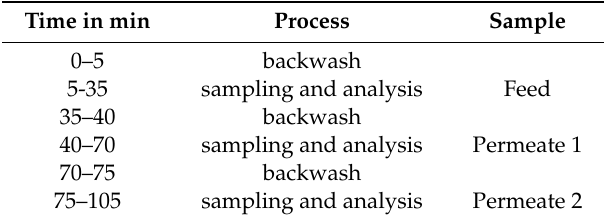
Figure 1. Scheme of online flow-cytometry (FCM) sampling system. Table 1. Of water sample analysis within a measurement cycle of 105 min.